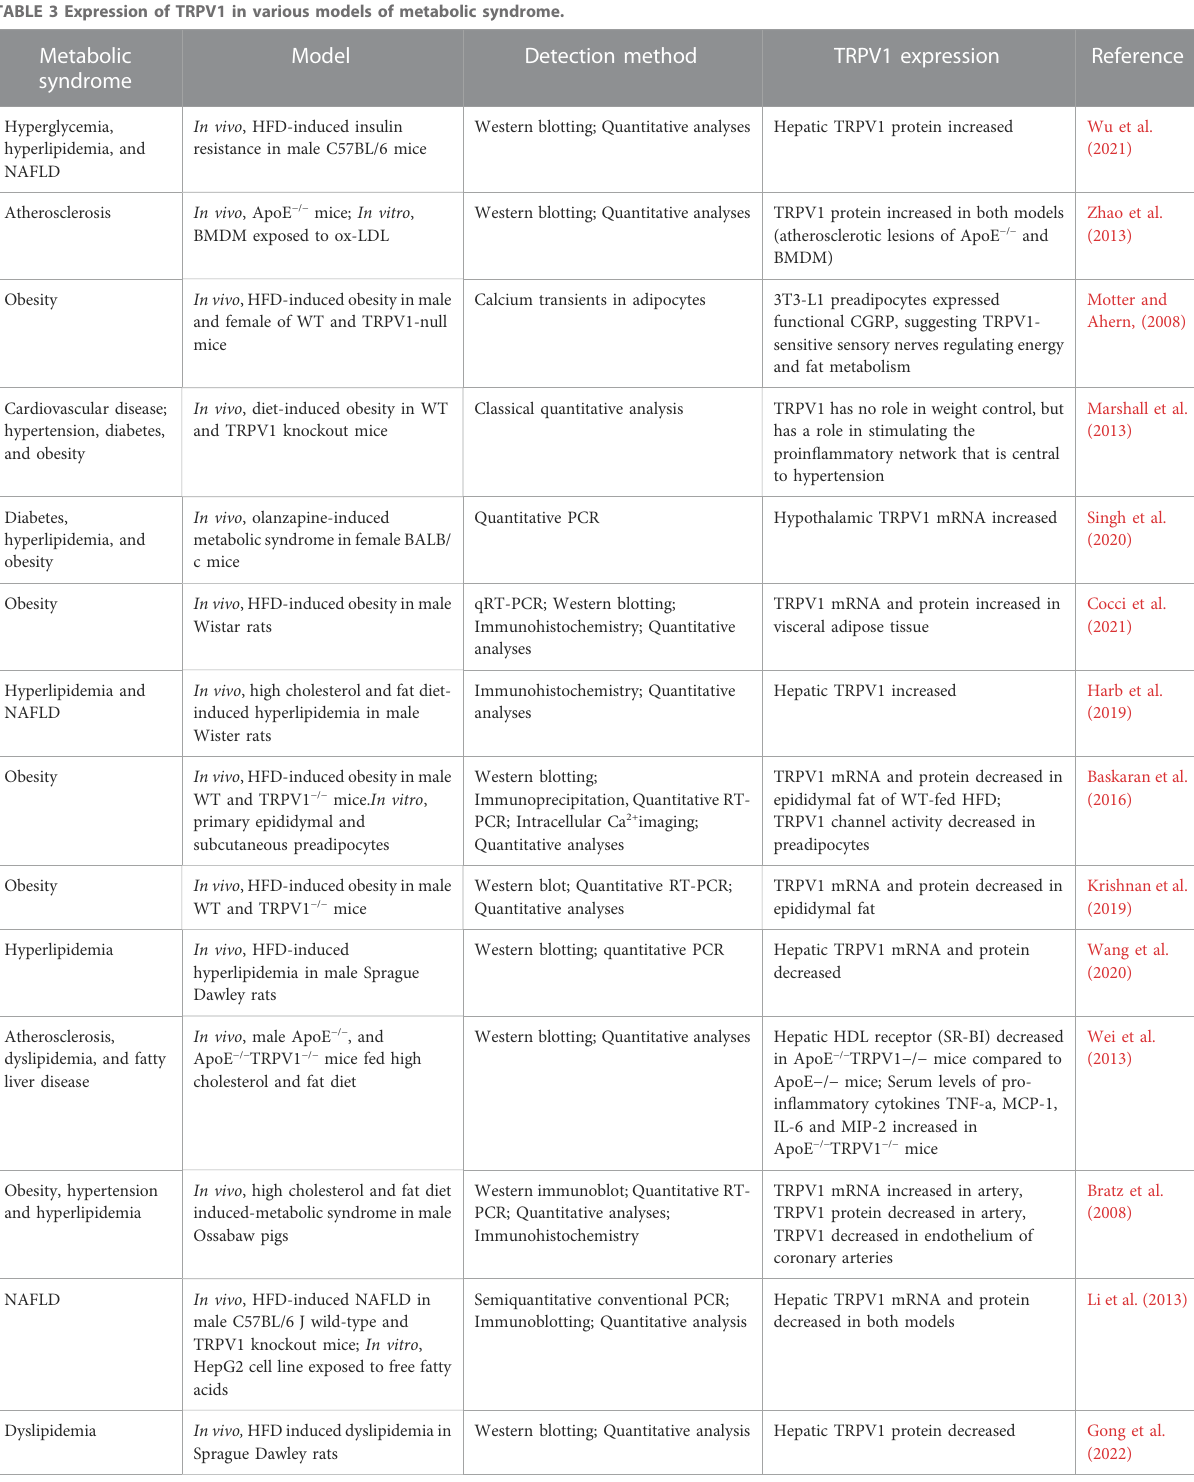
TABLE 3 Expression of TRPV1 in various models of metabolic